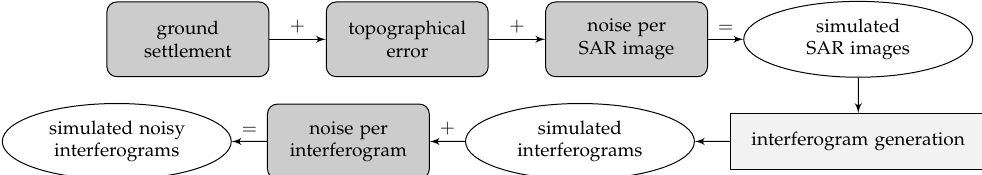
Figure 5. Workflow for generating simulated interferometric phases. The simulated SAR images consist of a ground settlement, a topographical error and a noise part. On this basis, interferograms are generated, which in turn are provided with noise.